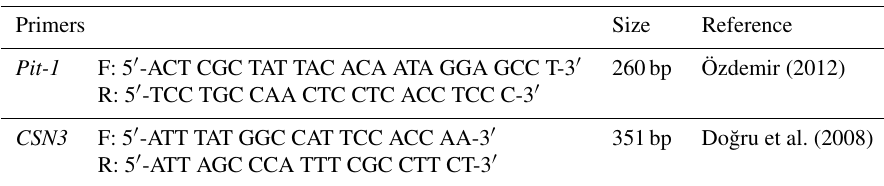
Table 1. Primer sequences of Pit-1 and CSN3 genes.